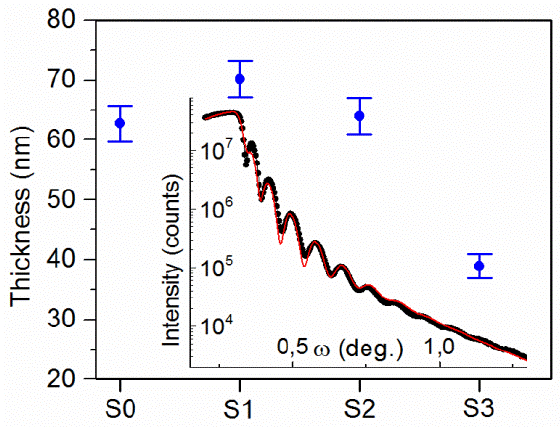
Figure 3. Films thicknesses for samples with different Ga concentration. In the insert, the XRR spectrum obtained for sample S4 with about 16 at.% of gallium is shown.